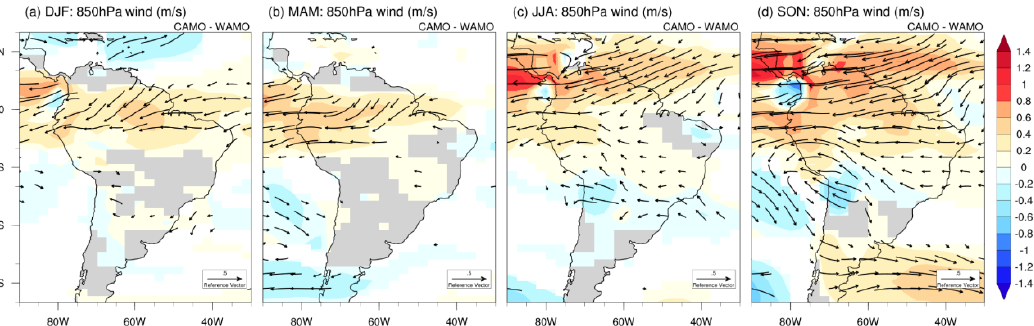
Figure 4. Seasonal wind vectors and intensity at 850 hPa (m/s) for the differences between the cold Atlantic Multidecadal Oscillation (CAMO) and the warm Atlantic Multidecadal Oscillation (WAMO) phases in ( a ) December–February (DJF), ( b ) March–May (MAM), ( c ) June–August (JJA), and ( d ) September–November (SON). Only statistically significant differences calculated using Student’s t test with confidence level of 95% are shown.